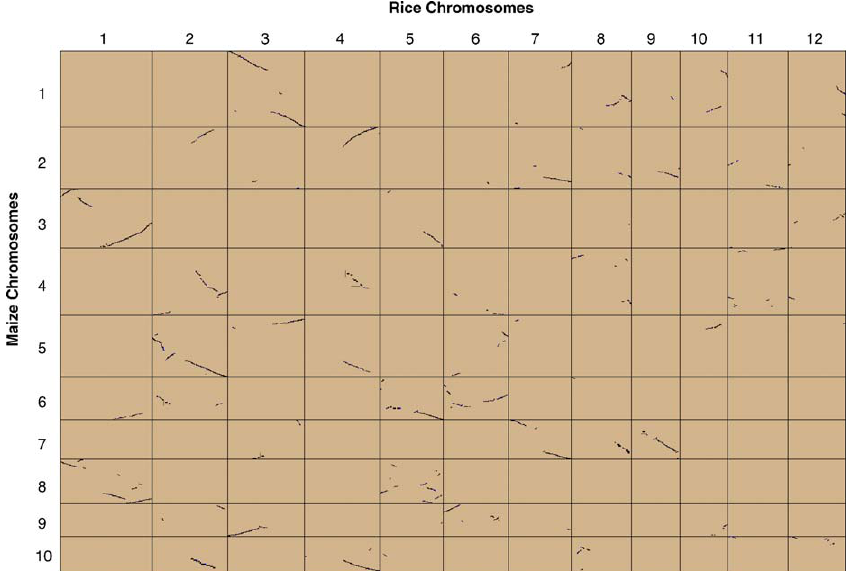
Figure 1. Dotplot Analysis of the Integrated Maize Map against Rice Pseudomolecules Synteny blocks were detected, and background noise was filtered with SyMAP [37]. The interactive dotplot can be viewed at http://www.agcol.arizona. edu/symap. When clicking the related synteny block, the detailed window with contig number will pop up. The viewer can select the preferred area and double click the selection, and then a graphic alignment is displayed.